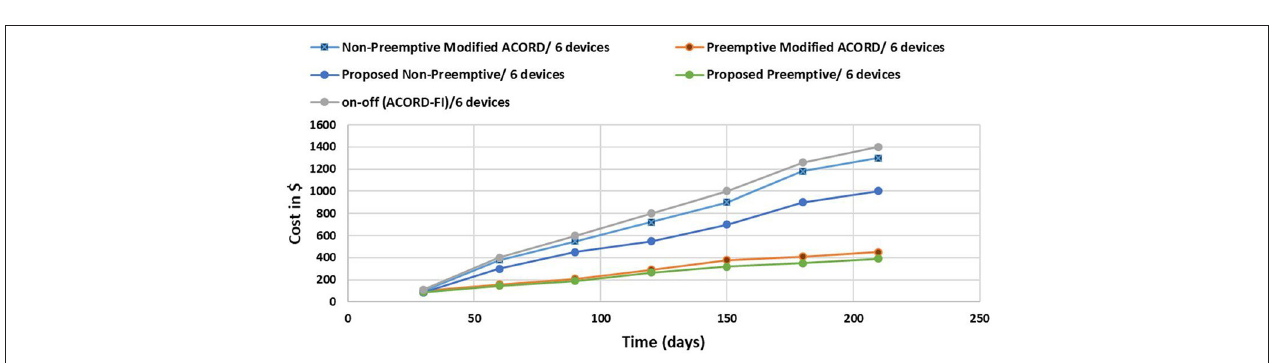
FIGURE 8 | Total energy cost of using 4 appliances with price model 2.